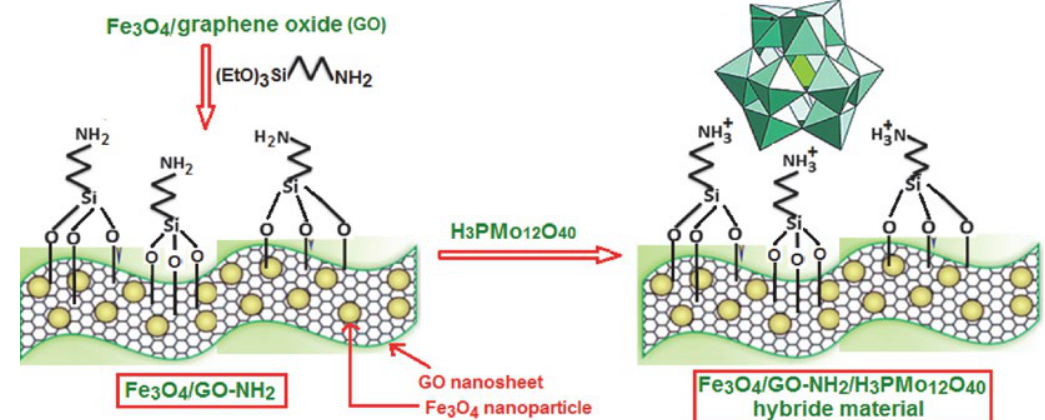
Figure 1. The preparation procedure to attach H